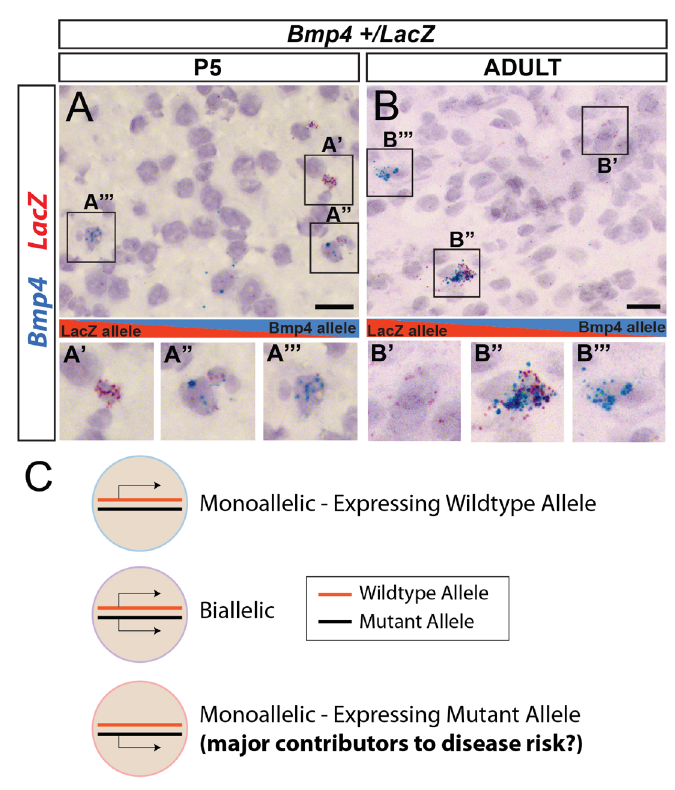
Figure 5. Interactions between non-genetic allelic effects and heterozygous variants can shape genetic architecture at the cellular level. ( A , B ) Single-molecule mRNA in situ hybridization for the mutant ( LacZ , red) and wild-type ( Bmp4 , blue) alleles in a heterozygous knockout reporter Bmp4 LacZ/+ mouse line. Images of the postnatal day 5 (P5) and adult mouse brain are shown and reveal a mosaic of cells that preferentially express the mutant allele (red; A ’ and B ’), wild-type allele (blue; A ’’ and B ’’), and biallelic (red and blue co-expressed; A ’’’ and B ’’’) cells. ( C ) Monoallelic mutant allele-expressing cells might be more dysfunctional than biallelic or monoallelic wild-type allele-expressing cells for some